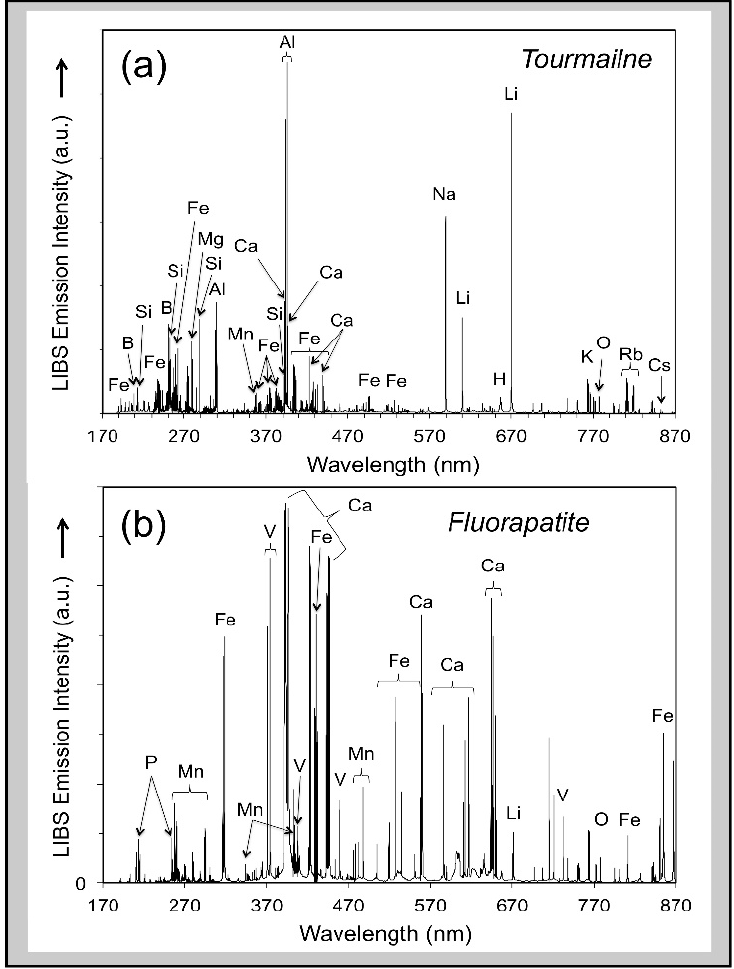
Figure 7. Handheld LIBS spectra between 170–870 nm for the pegmatite accessory minerals tourmaline ( a ) and fluorapatite ( b ) in pegmatite samples from the Carolina Lithium Project prospect in Gaston County, NC. The unlabeled peaks in the infrared portion of the spectrum between 700–870 nm are for the Ar purge gas used for the